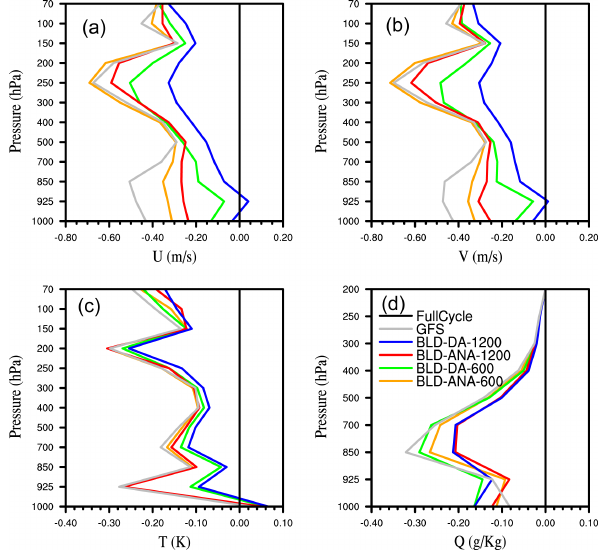
Figure 5. Same to Fig. 4 but for 24h forecast RMSD reduction compared to FullCycle. (a) u , (b) v , (c) T , and (d) q